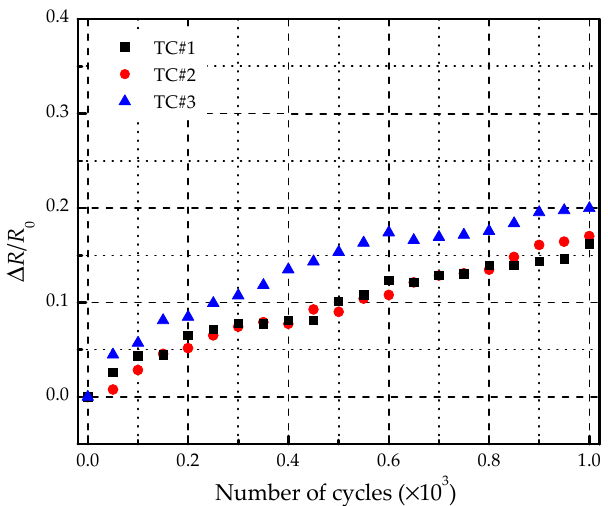
Figure 10. Variation of electric resistance along with the number of thermal cycles.